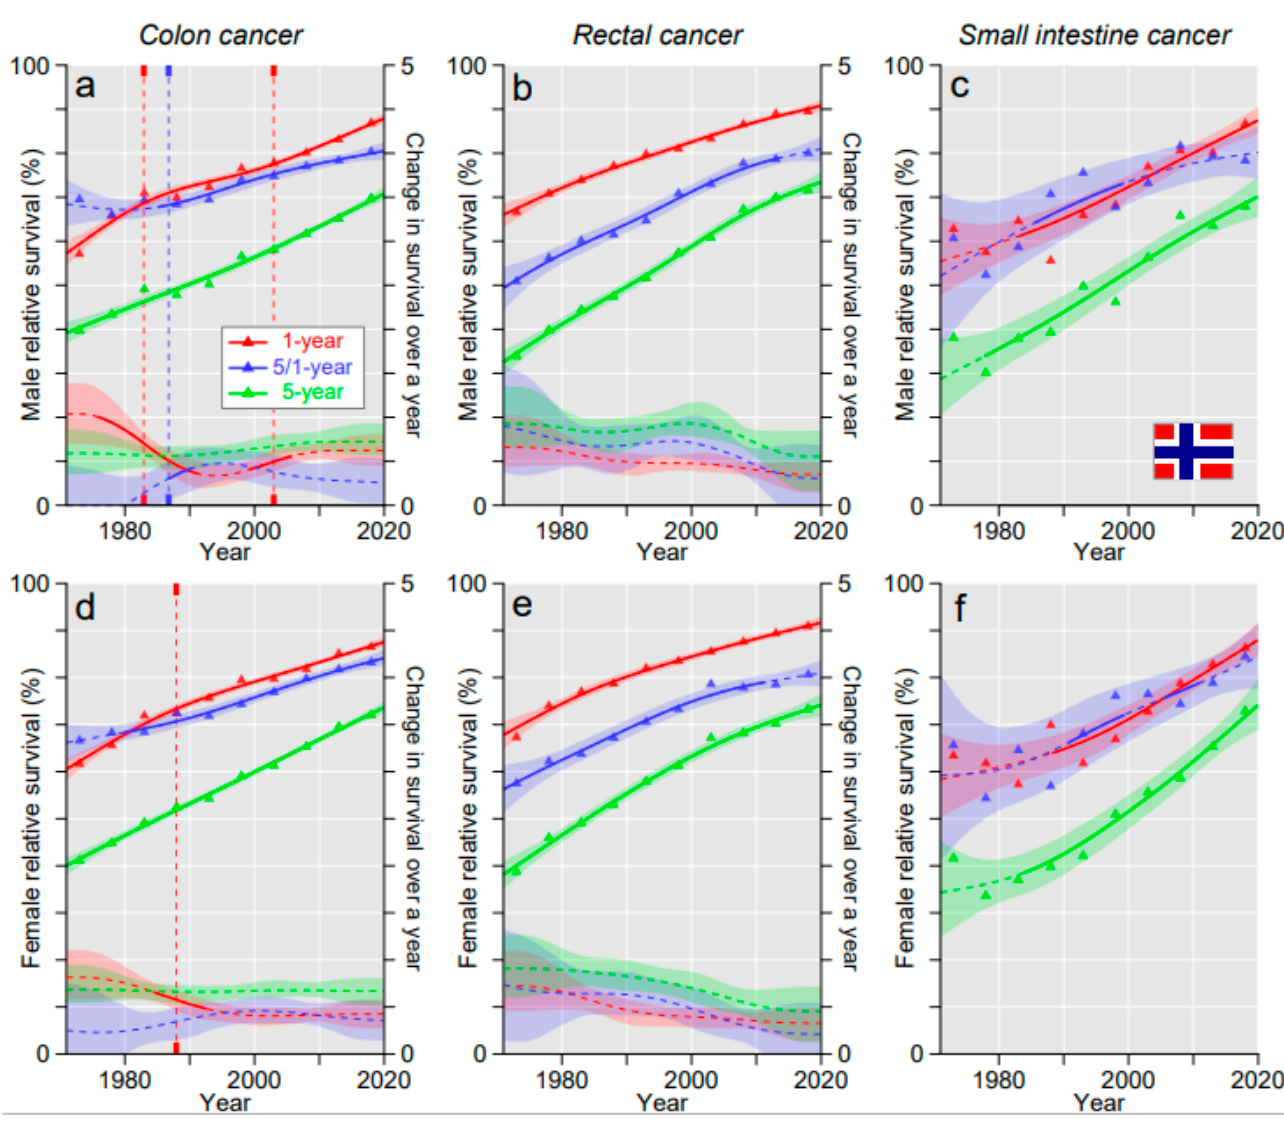
Figure 3. Relative 1- , 5/1- and 5-year survival in Norwegian men ( a – c ) and women ( d – f ) in colon ( a , d ), rectal ( b , e ) and small intestinal cancers ( c , f ). The vertical lines show significant breakpoints in survival trends and the bottom curves show estimated annual changes in survival. The solid lines in survival curves and annual change curve indicate a plausible trend (see Methods). All curves are color coded (see the insert).